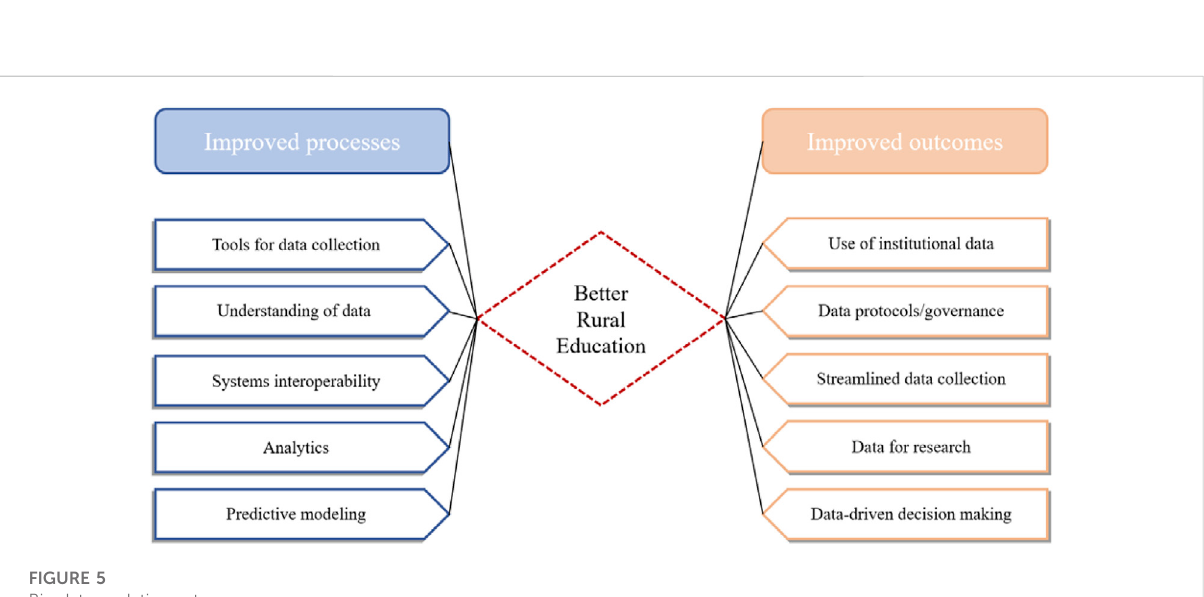
FIGURE 5 Big data analytics